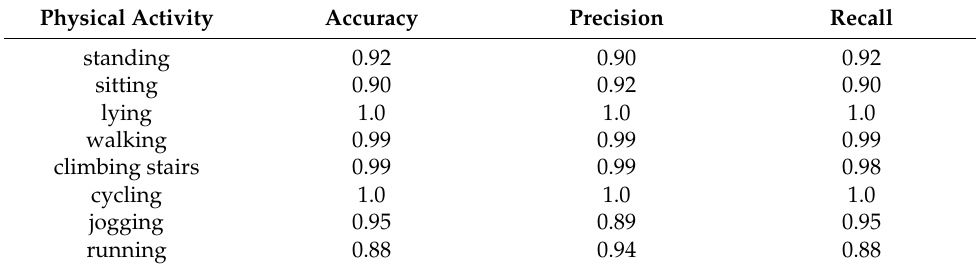
Table 4. Activities’ recognition rate using the two-layer multimodal fusion